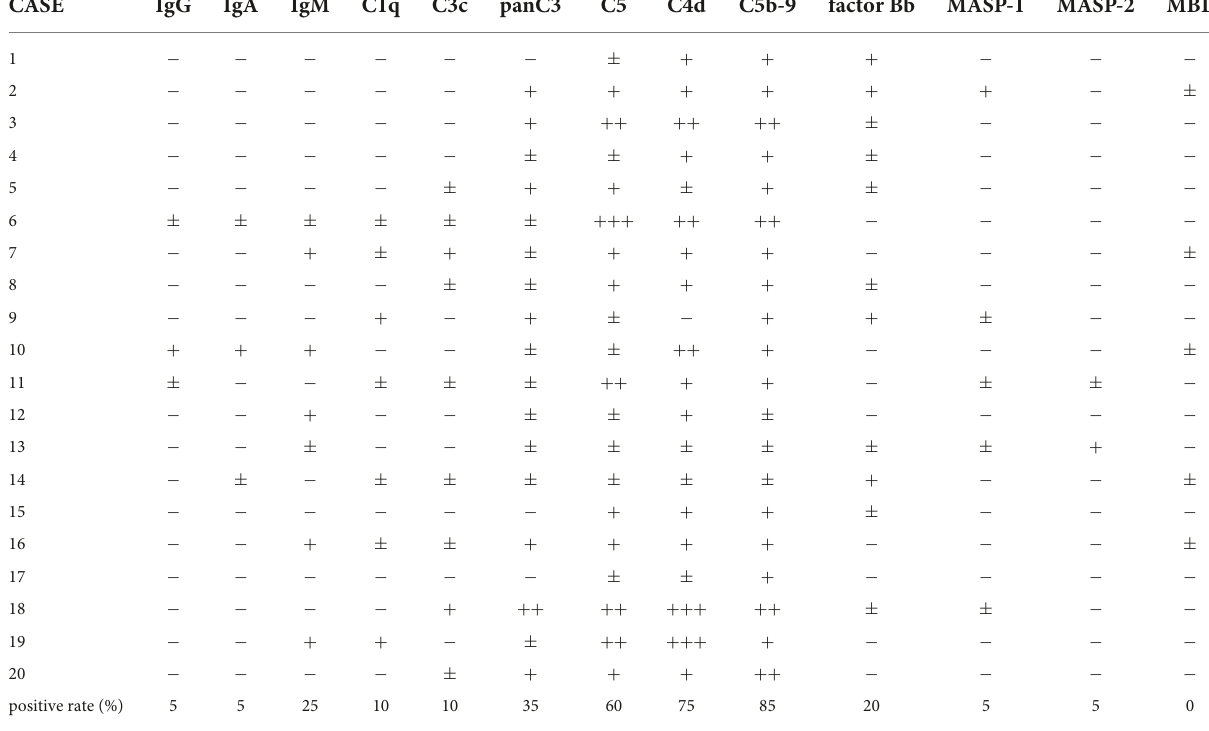
TABLE 1 Results of immunofluorescence staining in 20 patients with ANCA associated glomerulonephritis (AAGN).